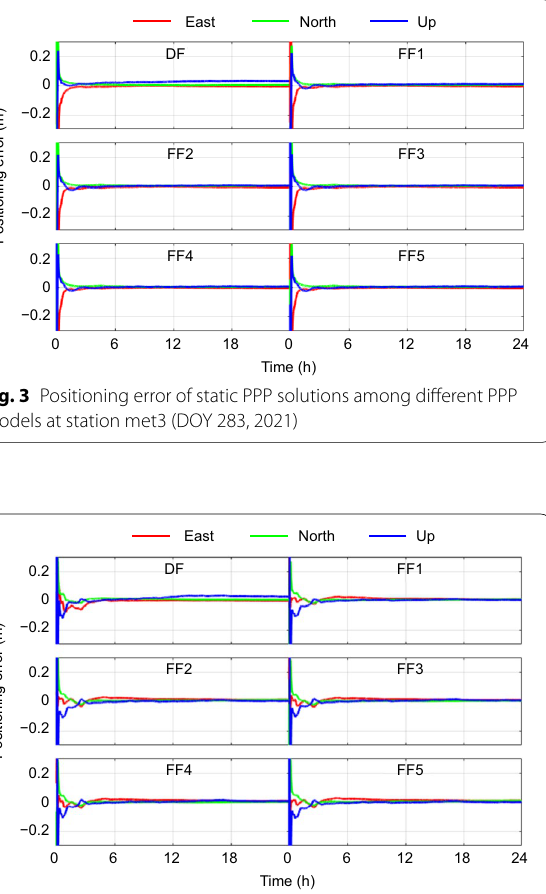
Fig. 4 Positioning error of static PPP solutions among different PPP models at station urum (DOY 283, 2021)